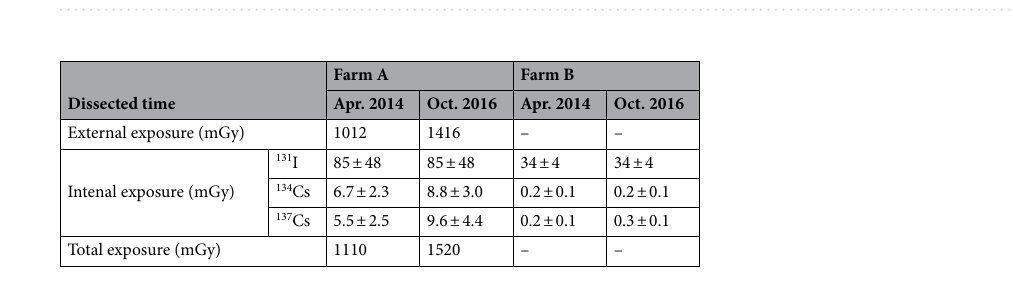
Table 1. The total exposure of cattle thyroid in Farm A and